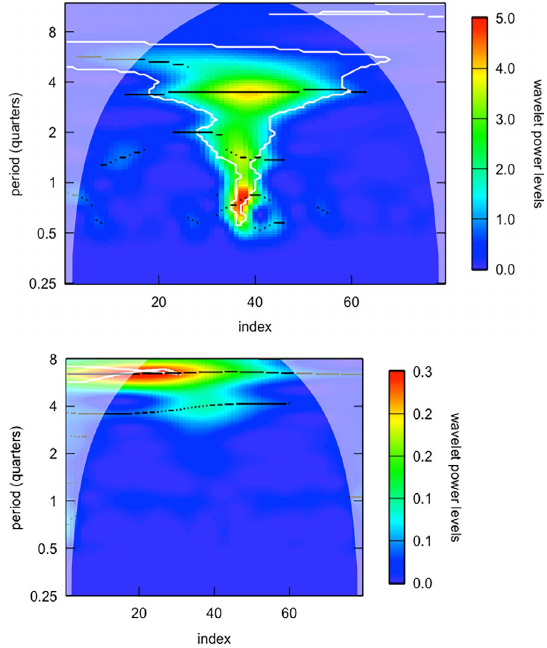
Figure 1. Wavelet power spectrum Euro area GDP growth rate and public